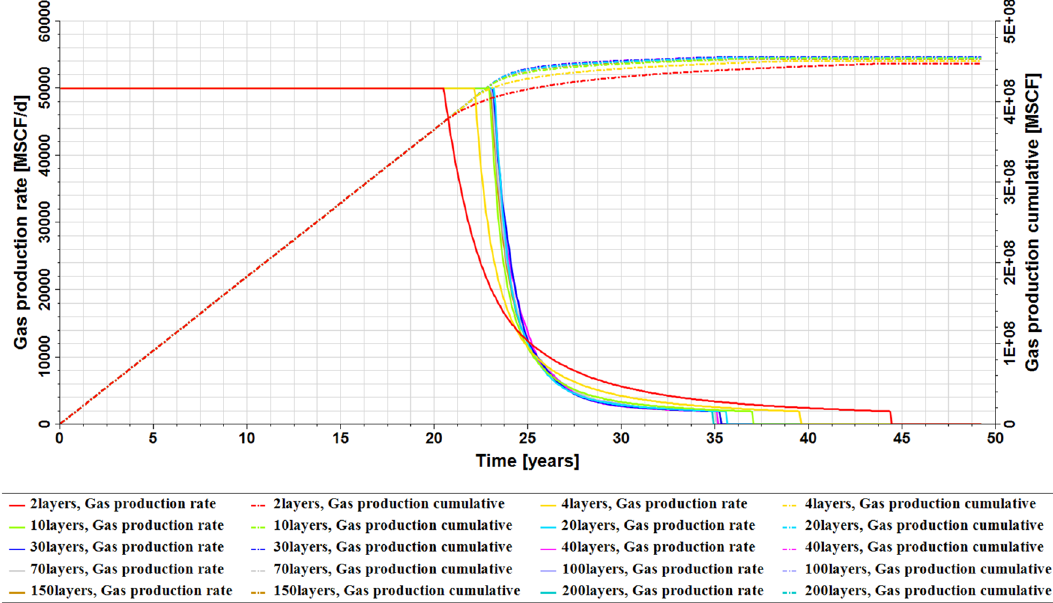
Fig. 9 Gas production rate and cumulative gas production for models with different